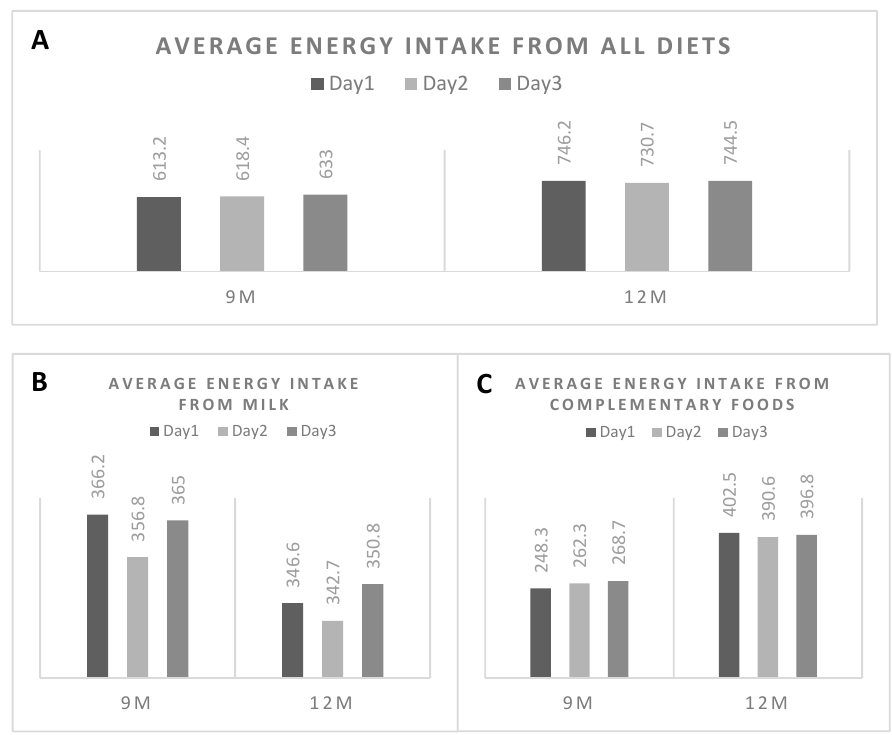
Figure 3. Variation in daily energy intake from 3-days food records. ( A ) shows the variation in total energy intake (kcal/day) at 9 and 12 months, while ( B , C ) demonstrate the variation in energy intakes from milk and complementary foods, respectively.